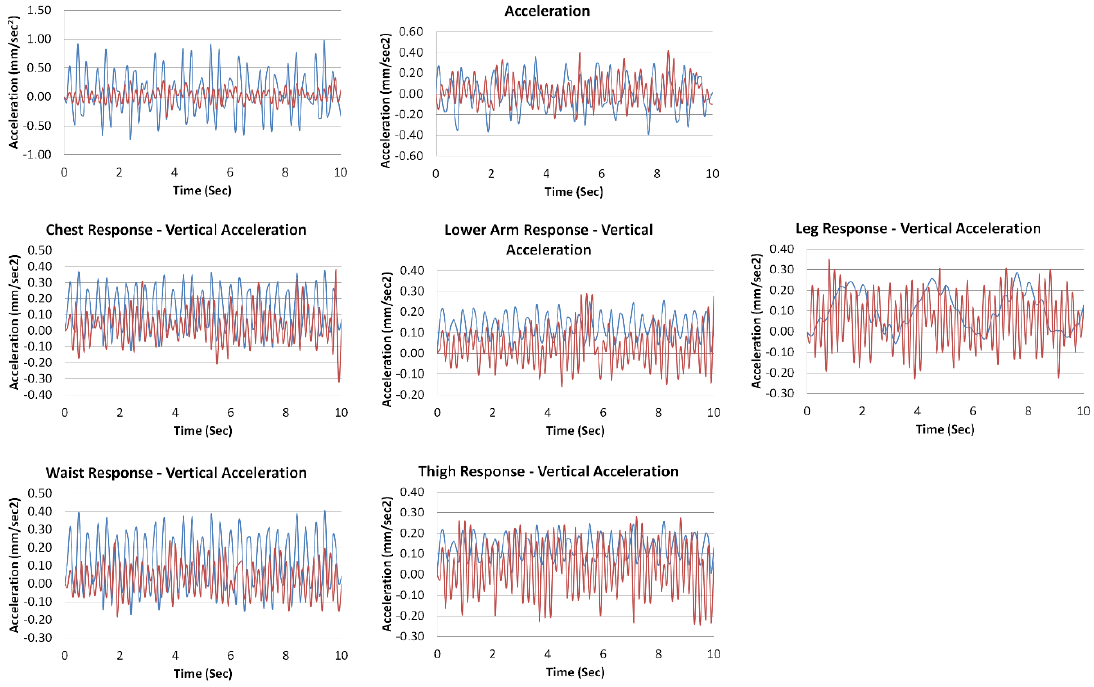
Figure 10. Vertical accelerations of human segments from simulation (blue) and testing (red).